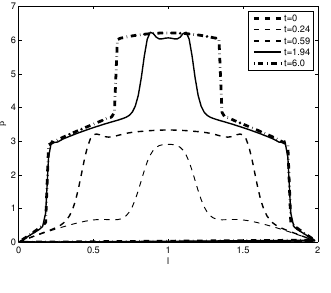
Figure 9. Droplet dynamics at ωτ = 0 ⇒ 8, t f = 6.